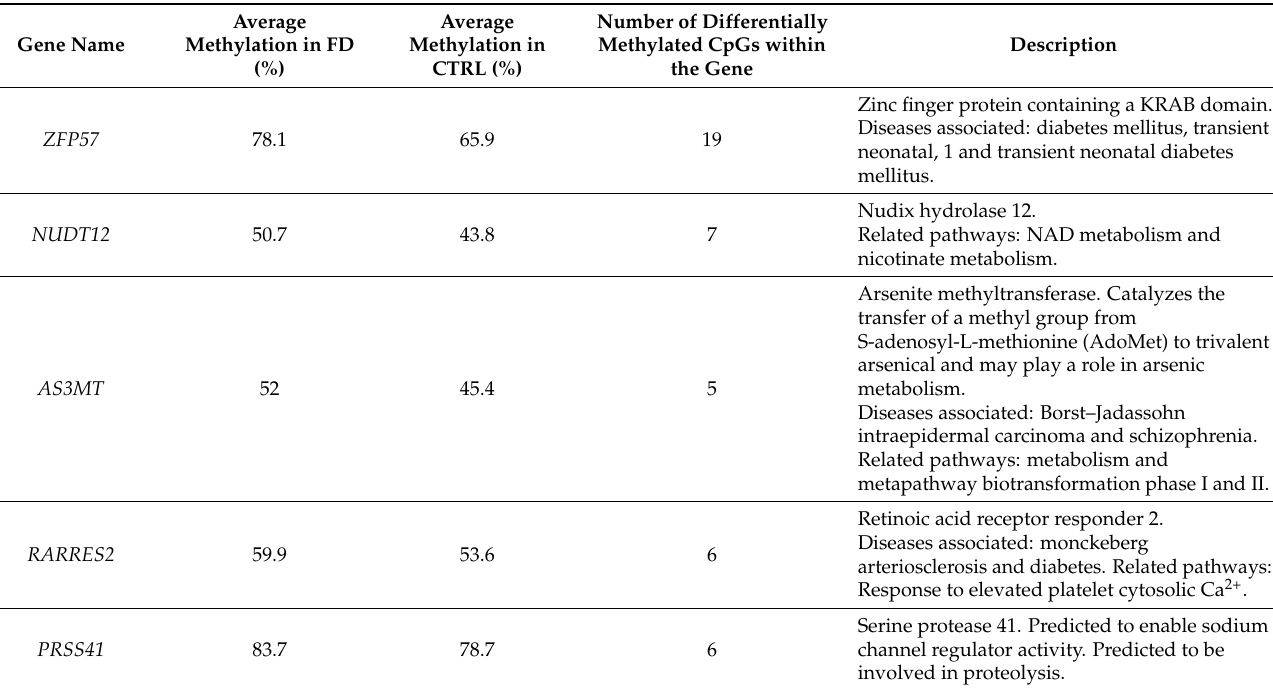
Table 2. Differentially methylated genes with high degree of methylation in FD.